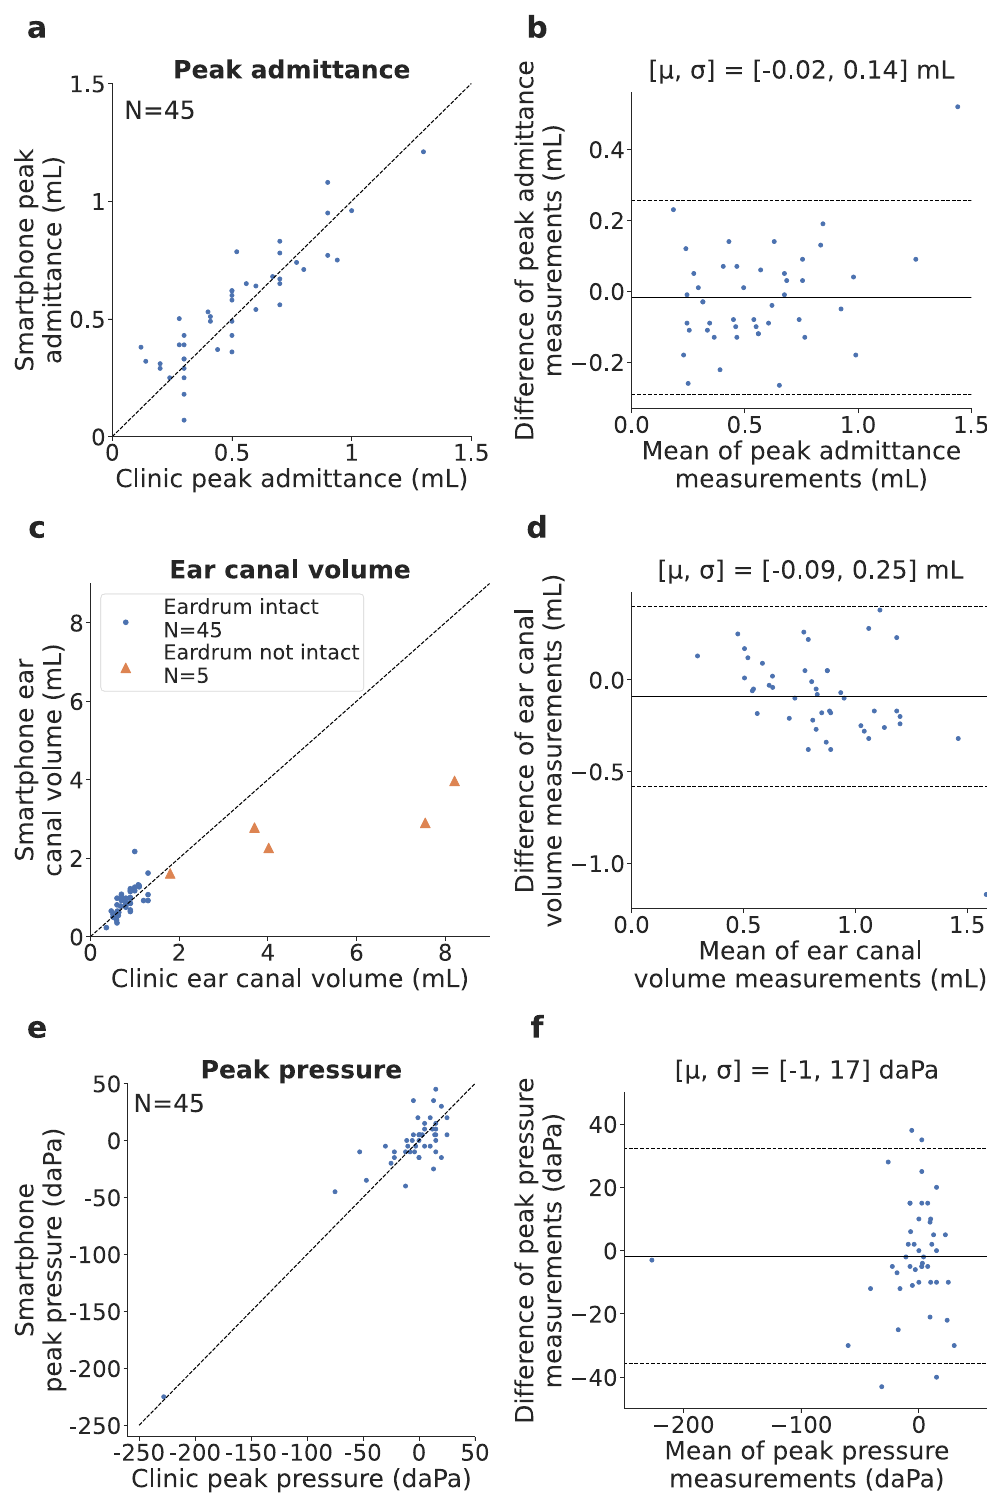
Fig. 5 Clinical study performance. a , c , e Correlation and b , d , f Bland-Altman plots compare peak admittance, ear canal volume and peak pressure obtained from the commercial tympanometer and smartphone-based tympanometer. In the Bland-Altman plot μ indicates bias error (mean of the differences) between measurements and σ is the standard deviation (SD) of measurement error. The solid and dotted lines represent the bias error and 95% limits of agreement respectively. Source data are provided in Supplementary Data